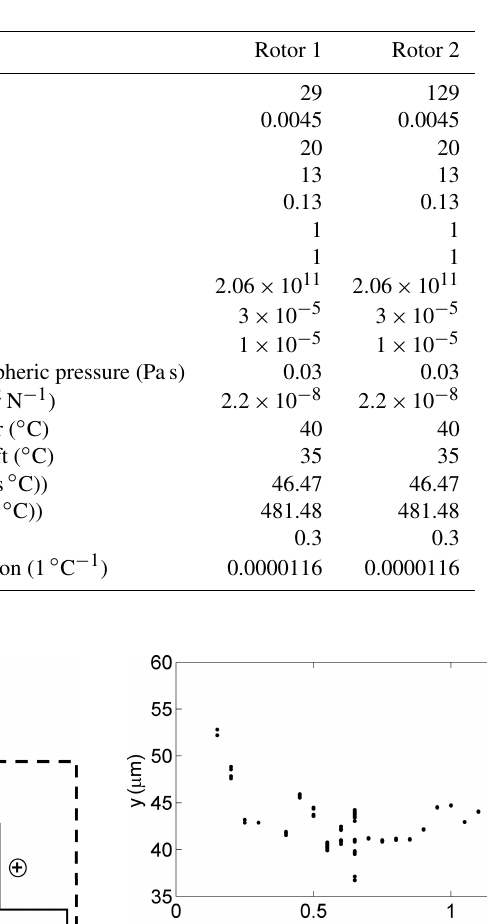
Table 2. Parameters of the helical gear pairs.